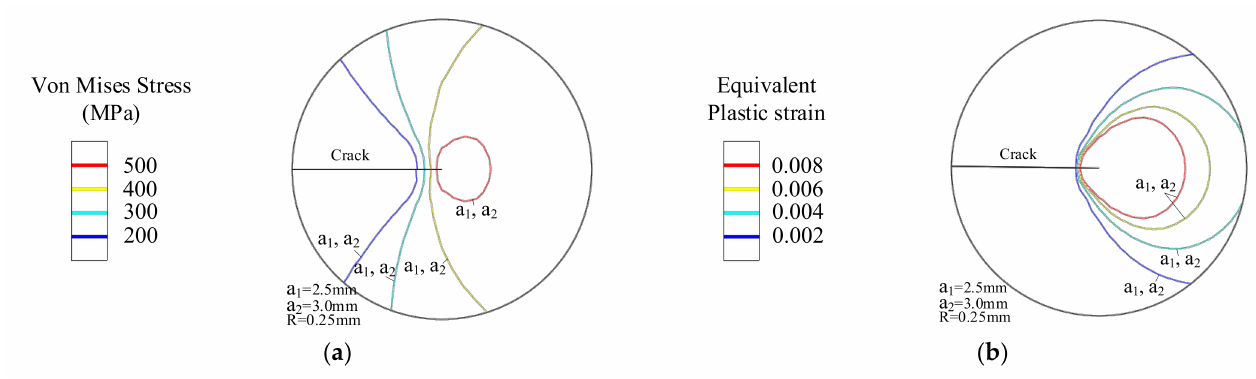
Figure 18. G y = 0 crack tip mechanical field. ( a ) Von Mises stress contour and ( b ) Equivalent plastic strain